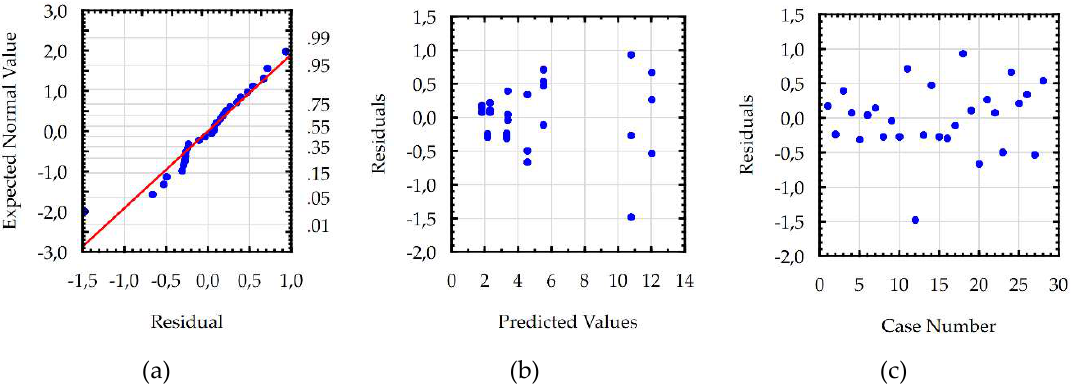
Figure 11. The plots to check the model for surface roughness (Sa) : ( a ) the normal plot of residuals; ( b ) the residuals versus the predicted values; and ( c ) the residuals versus the case values.